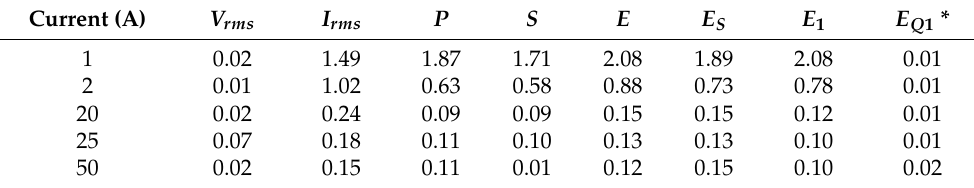
Table A4. Peaked test